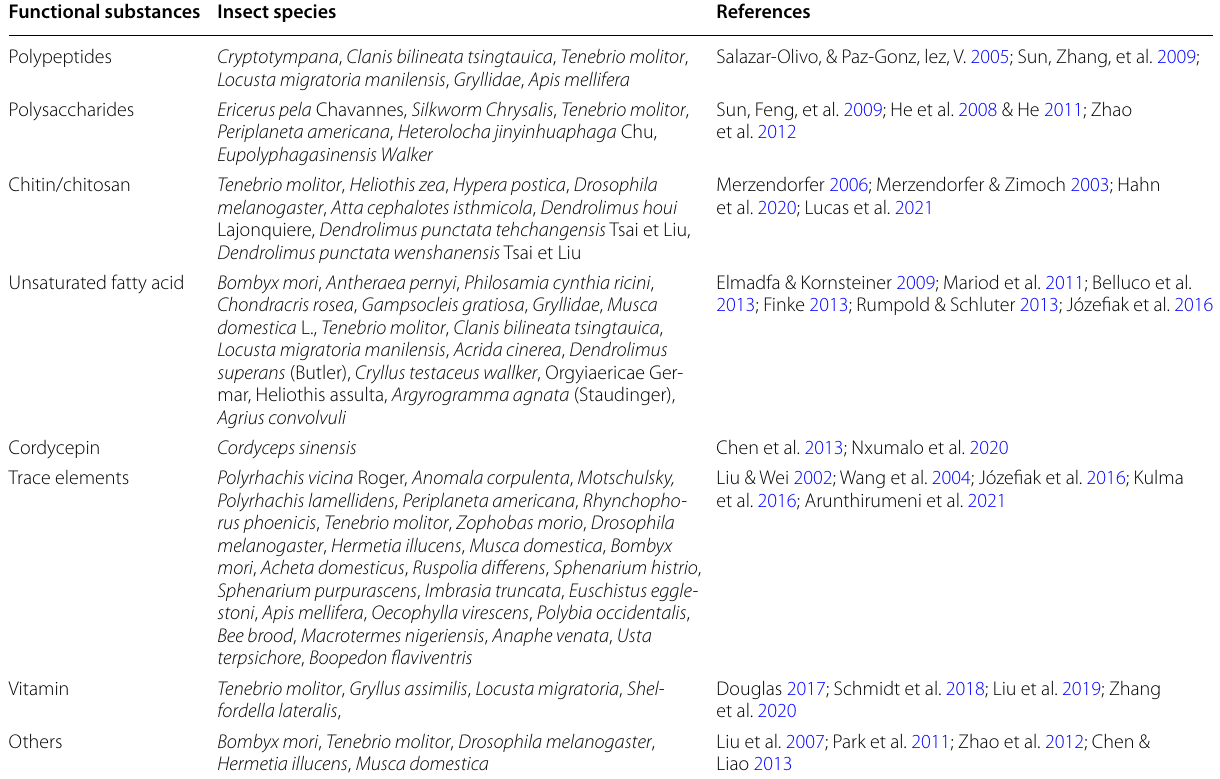
Others - including alkaloids, fibroin, flavonoid, insect hormones, and other functional substances of reducing blood sugar in edible insects